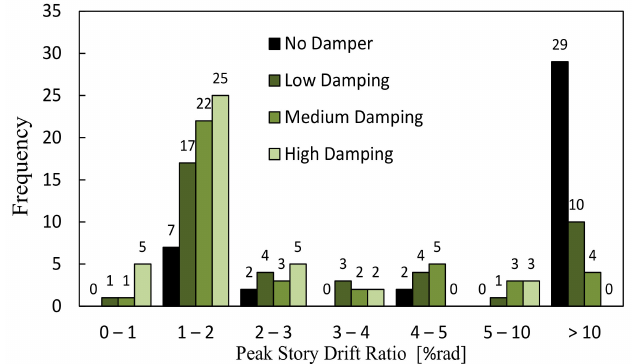
Figure 11. Comparison of peak SDRs at BSE-2E level for different damping levels.